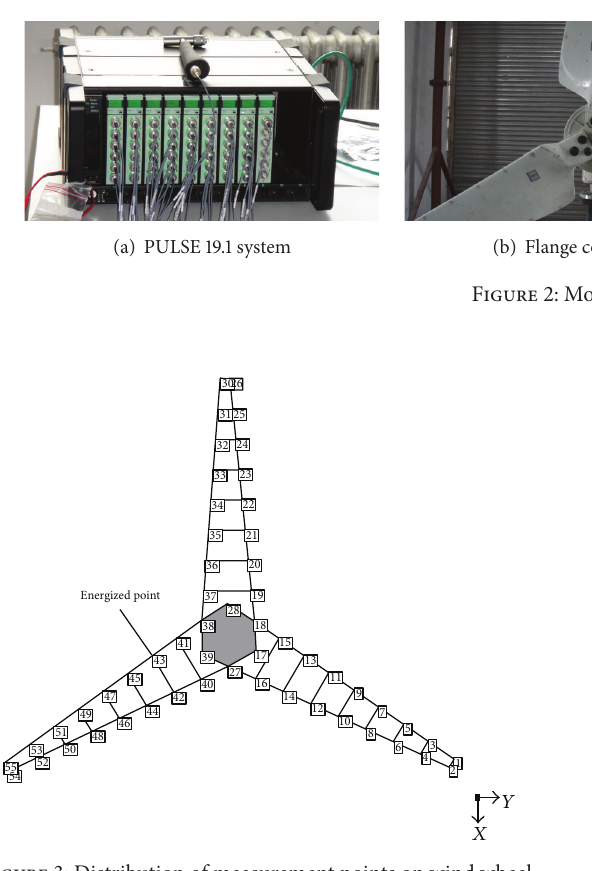
Figure 3: Distribution of measurement points on wind wheel.